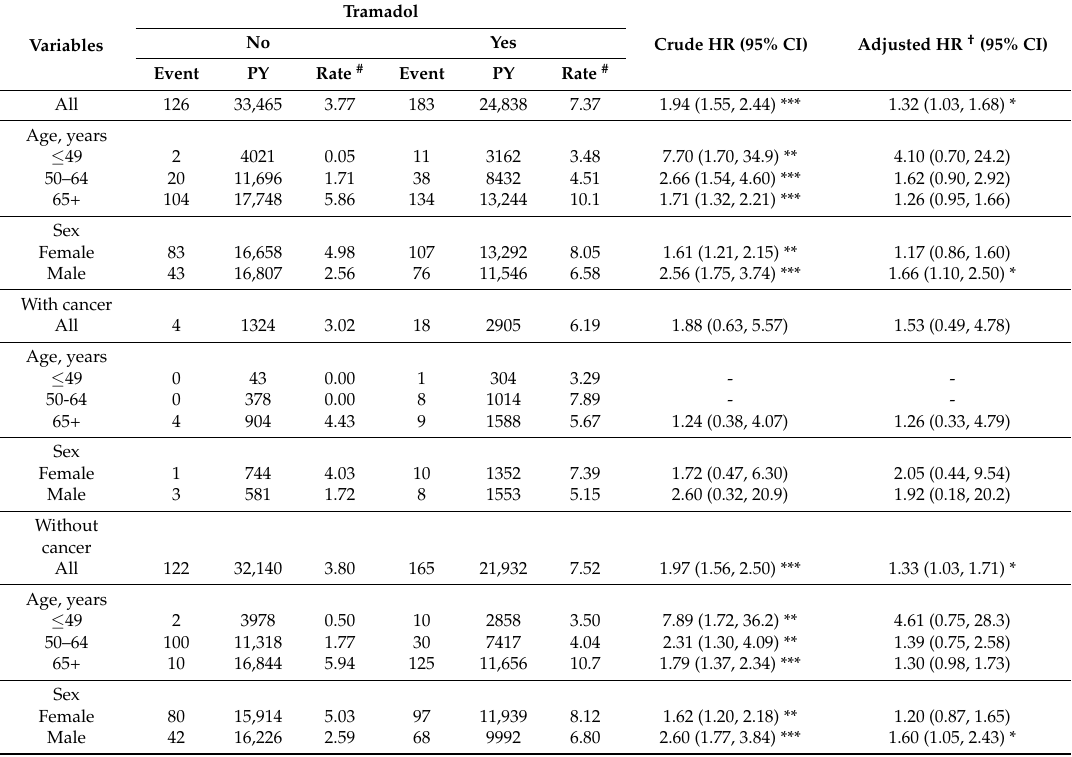
Table 2. Comparisons of hypoglycemia incidences between diabetes patients with and without tramadol use and associated hazard ratios by age, sex and